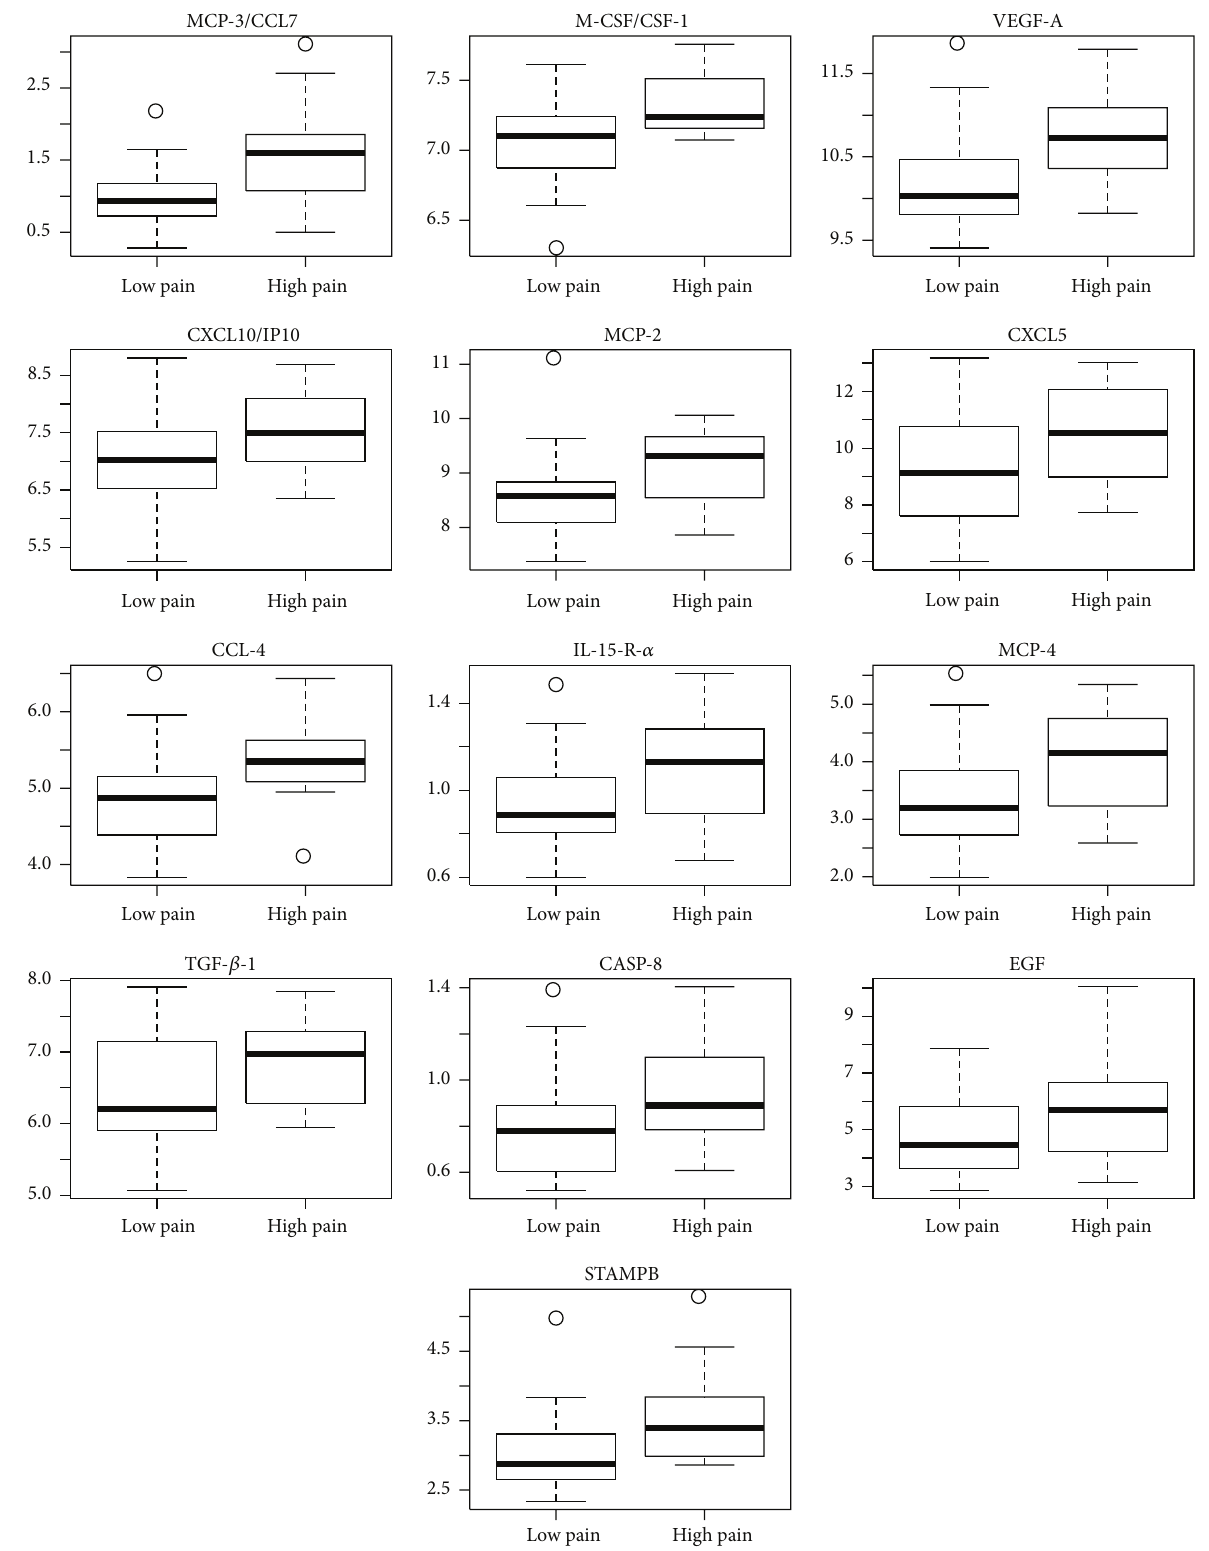
Figure 3: The expression of the 13 most significant proteins (FDR < 0.05). All 45 patients were included. The data are shown by box plot; median and IQR ±